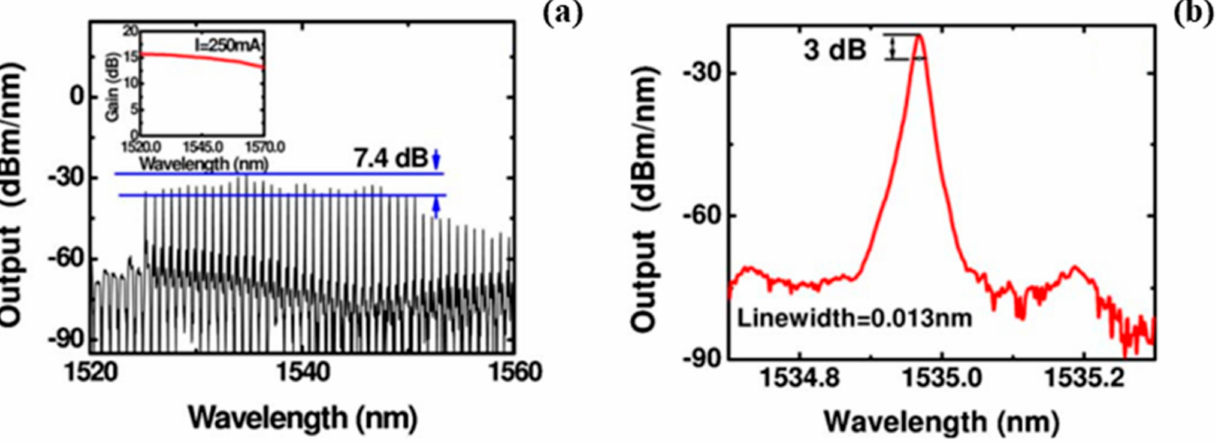
Figure 21. Output spectra of the comb filter-based multiwavelength fiber laser. ( a ) Laser emissions with 51 channels and ( b ) emission in one of the channels. Adapted with permission from ref. [122]. © The Optical